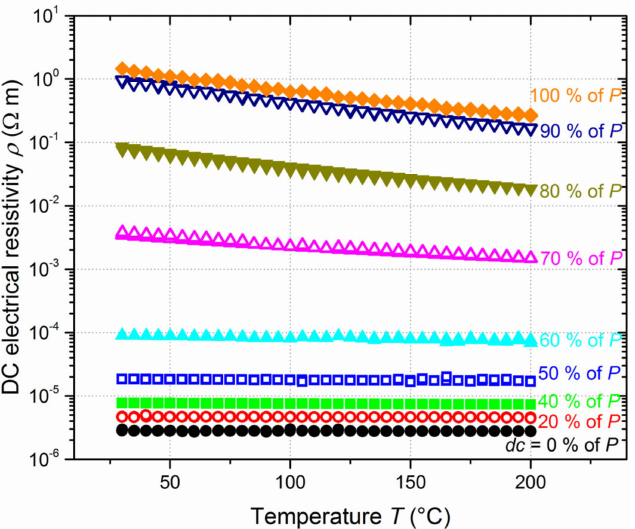
Figure 7. DC electrical resistivity ( ρ ) vs. temperature ( T ) measured on Ti-B-N thin films deposited on glass for various duty cycles ( dc = 0 to 100% of the constant pulsing period of P = 10